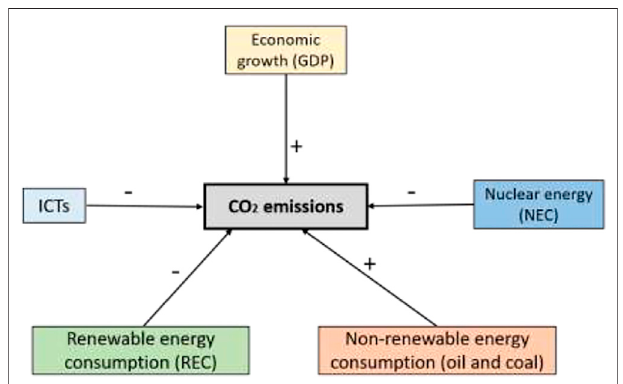
FIGURE 1 | Conceptual framework of this